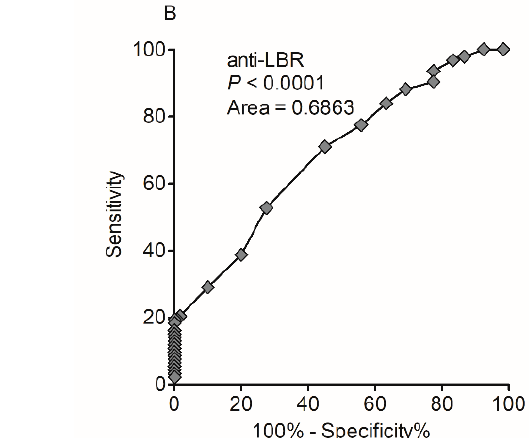
Figure 2. Receiver operating characteristic (ROC) curve analysis for serological detection of PBC anti-gp210 and anti-p62, and anti-LBR antibodies in PBC: ( A ) anti-gp210 and anti-62, ( B ) anti-LBR. The determined area under the ROC curve (AUC) was greatest for anti-gp210 anti- bodies (0.7656). The values of AUC calculated for anti-LBR and anti-p62 autoantibodies were 0.6863 and 0.6608, respectively.